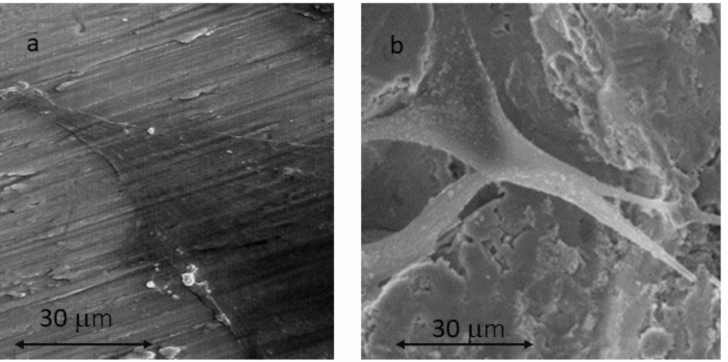
Figure 4. SaOS-2 osteoblastic cells observed using SEM at 21 days for MA surface ( a ) and SB+AE surface ( b ).